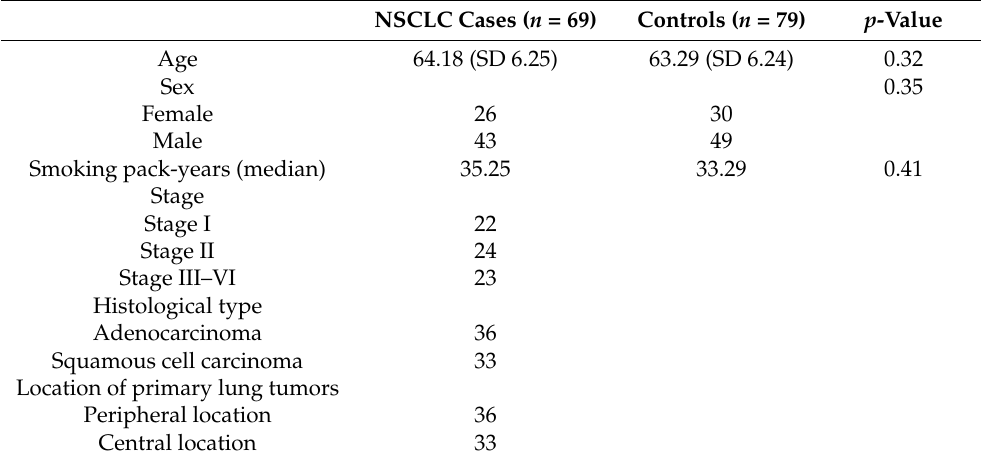
Table 2. Cohort 2 of NSCLC patients and cancer-free smokers from whom sputum specimens were